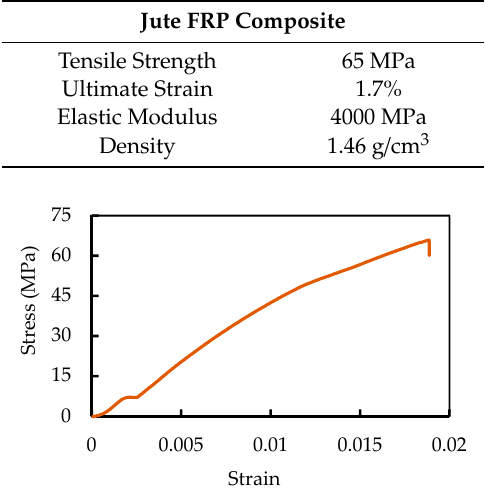
Table 4. Mechanical properties of the jute fiber reinforced polymer (JFRP).